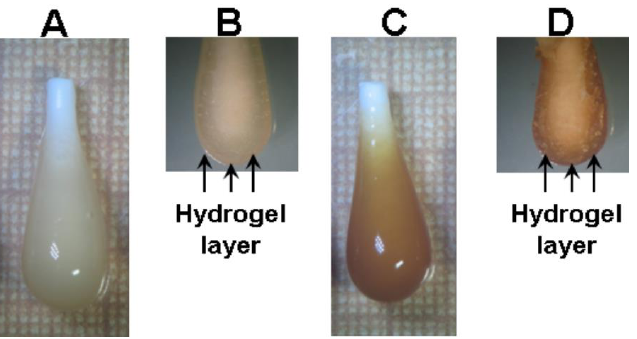
Figure 15. Appearance of CaP ( A , B ) and FeP ( C , D ) hydrogel probes for adhesion tests. ( B , D ) — the gel layer closest to the observer was cut off to see the hydrogel layer (1 – 2 mm).